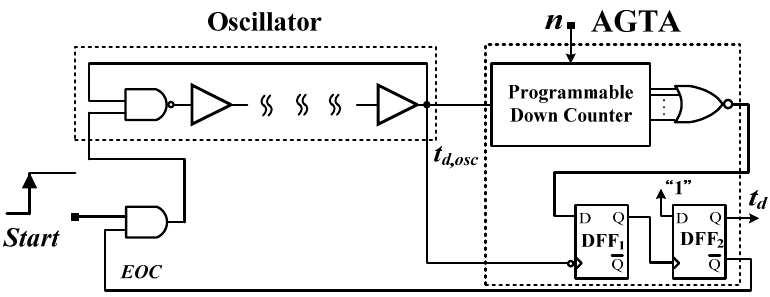
Figure 5. Circuits of the oscillator and the AGTA.